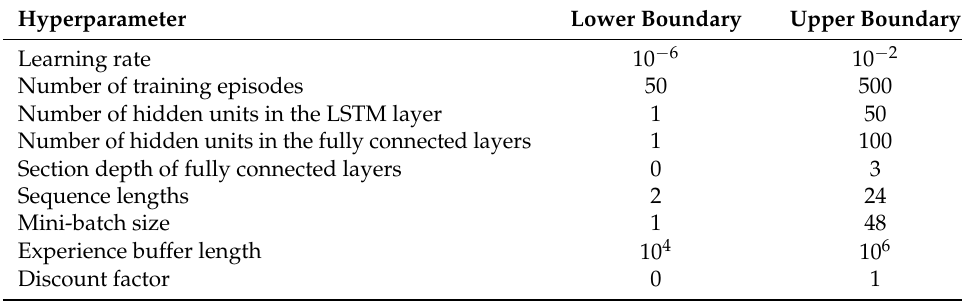
Table 3. Hyperparameters and their respective lower and upper boundaries. Hyperparameter Lower Boundary Upper Boundary Learning